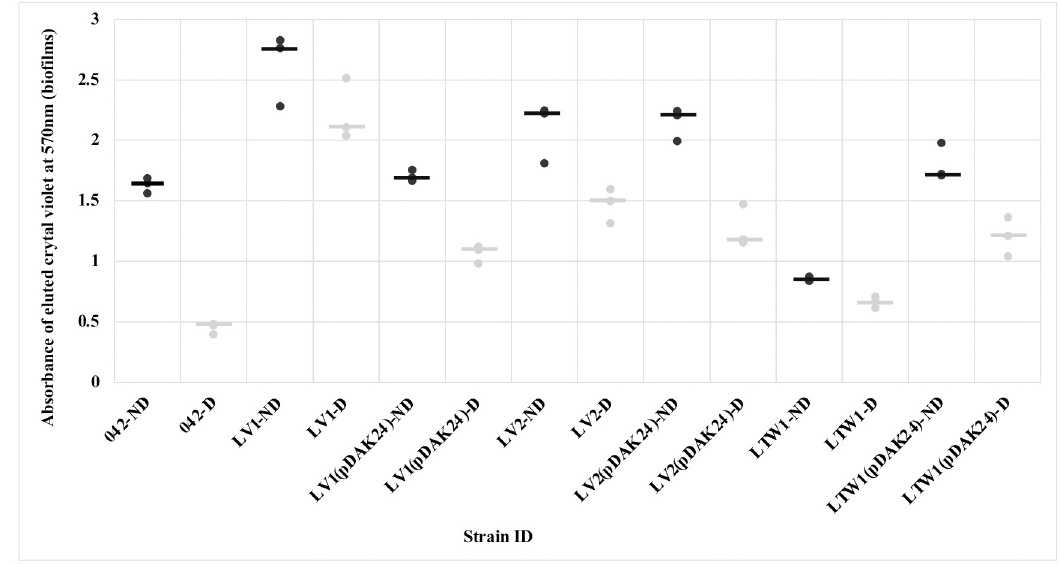
Fig 7. Biofilm inhibition of E . coli 042, 042 mutants and aap complimented strains by MMV687800. Biofilm formation (black) and inhibition by hit (grey). 042 is the prototypical EAEC strain from Peru, LV1: 042 Δ aap , LV2; 042 Δ aap Δ hra1 and LTW1: 042 Δ aap Δ aafA . LV1(pDAK24), LV2(pDAK24), and LTW1(pDAK24) are complement strains of LV1, LV2 and LTW1 mutants with aap inserts. Biofilm was significantly inhibited ( � = P < 0.05) in wild type strain, and in aap complemented strain, LV1 (pDAK24) compared to aap mutants (P > 0.05). This fulfils Molecular Koch’s postulates and confirms aap ’s involvement in biofilm inhibition by MMV687800. Statistical comparison was achieved between treated and untreated controls for each strain using student T-test, and bars represent medians of